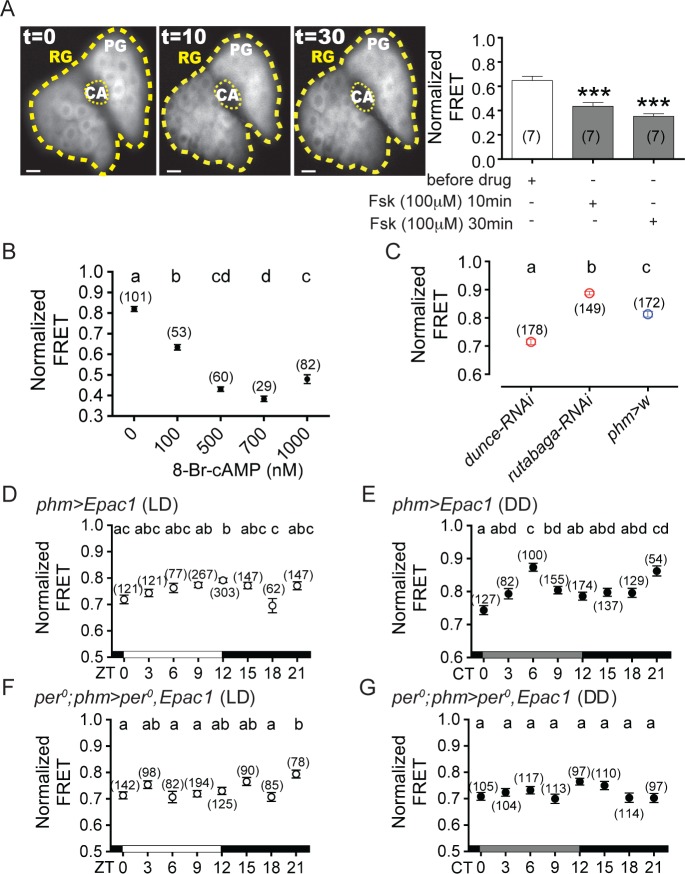
cAMP levels in the PG vary during the course of the day.(A) Left: Representative image of the signal from the cAMP sensor, Epac1, in the PG before (t = 0), and 10min and 30 min after incubation with 100μM forskolin (FSK); right: quantitation of the signal; numbers in parenthesis indicate number of glands measured. (B) Dynamic range of the Epac1 sensor, determined using increasing concentrations of 8-Br-cAMP; n: number of prothoracic gland cells (taken from at least 4 PGs per condition). (C) cAMP levels in the PG in controls and in animals bearing knockdown of dunce and rutabaga in the PG (using phm-GAL4 driver)(all measured at ZT12). The number of cells analyzed is indicated above each circle. For each experiment 9–17 animals were examined. (D-G) cAMP levels in the PG of wildtype animals at different times of day under LD (D) and DD (E), and in per0 mutants under LD (F) and DD (G) conditions. Error bars denote SEM. In (A) ***p<0.0001 (paired t-test compared with signal measured prior to adding drug); scale bar, 10μm. In B-G, different letters indicate statistically significant values (ANOVA with Tukey’s post hoc test). The number of cells is indicated in brackets and above each error bars. In B-G: Normalized FRET signal is (YFP/CFP).